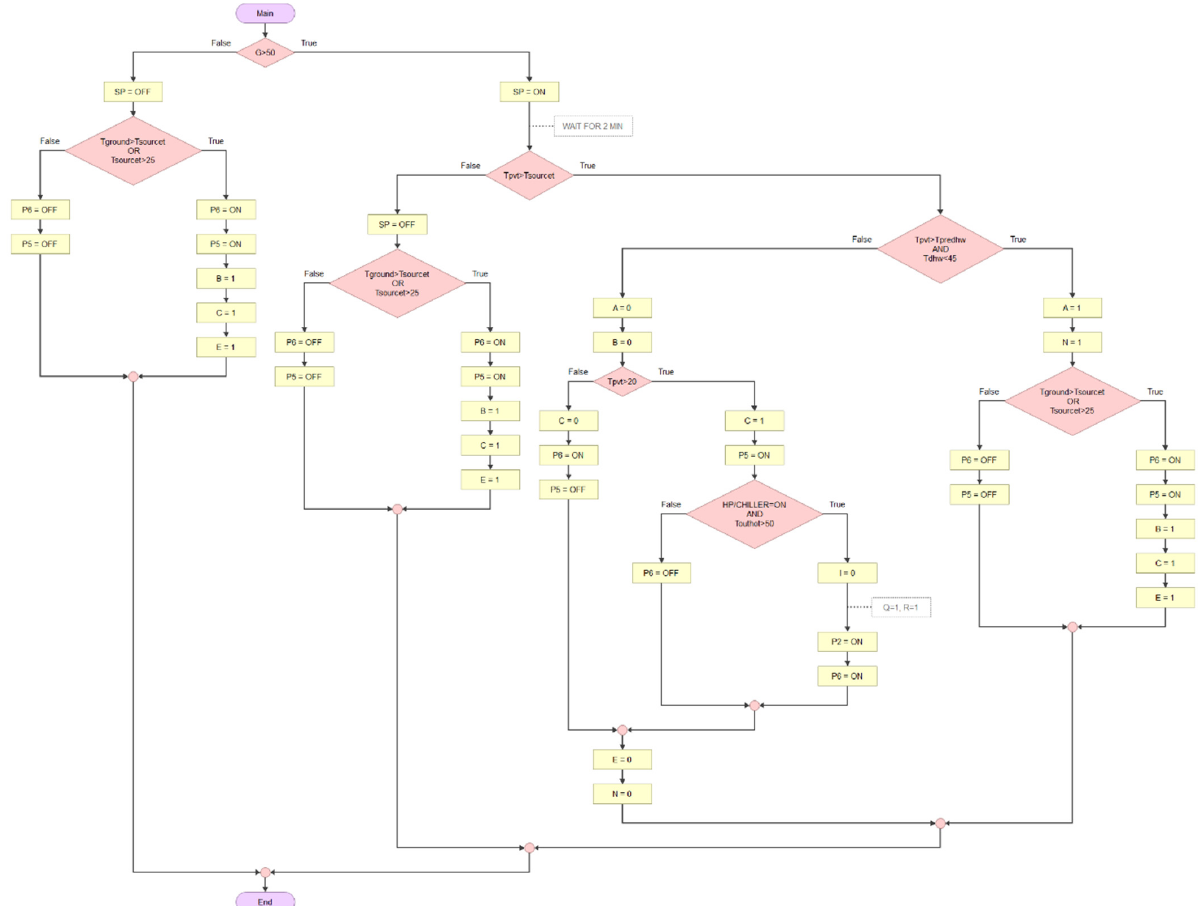
Figure 8. Flow chart of the control logic of PVT–source tank–ground loop.